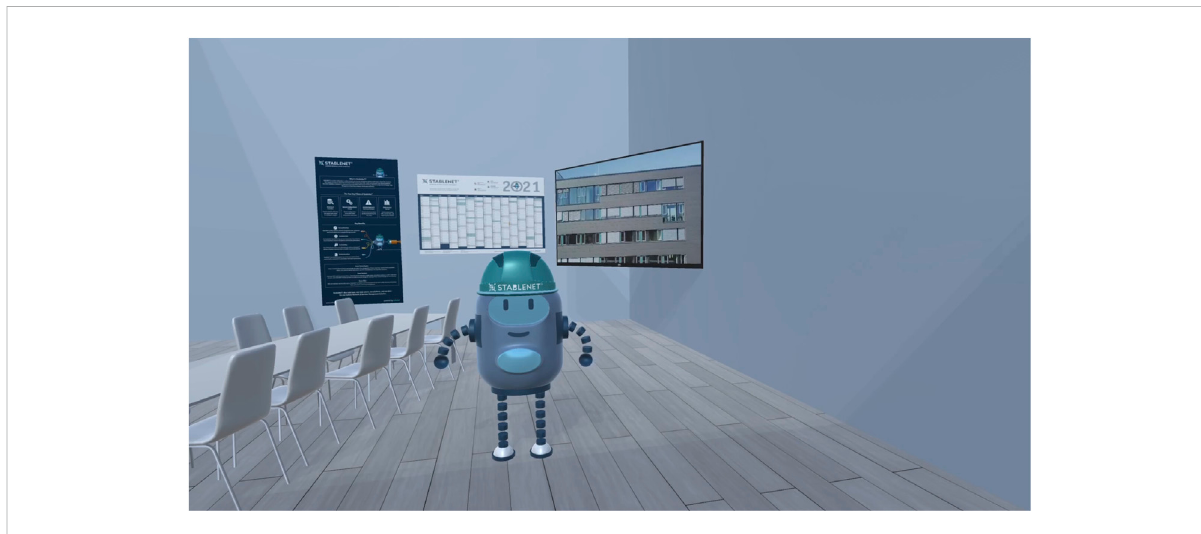
FIGURE 1 Screenshot of the virtual robot used in this